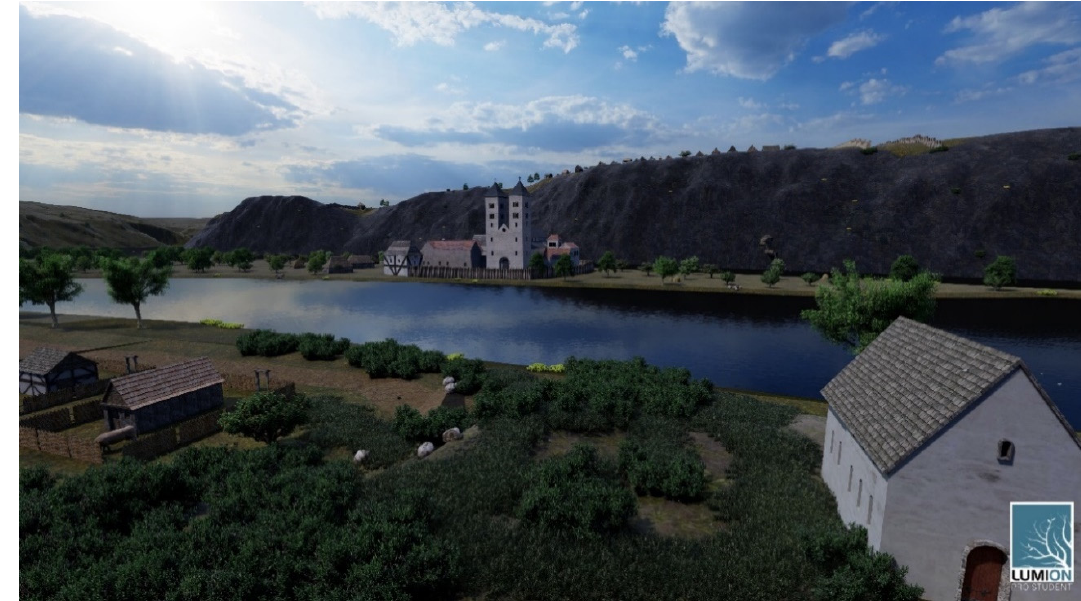
Figure A2. Visualization of Church of St. Kilián and the monastery in the Romanesque era.